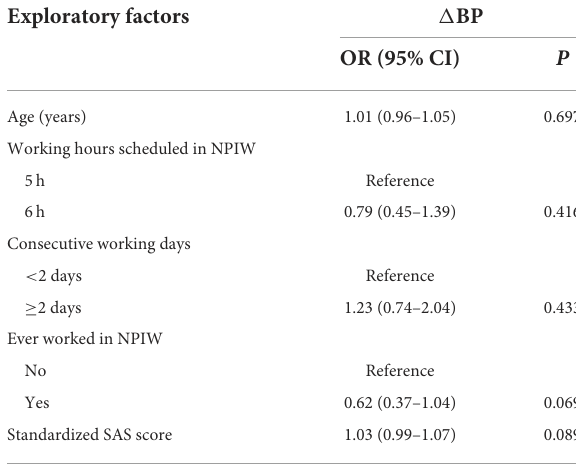
TABLE 4 Sensitivity analysis by the generalized estimated equation for the relationship between exploratory factors and 1 BP for nurses working in NPIW.